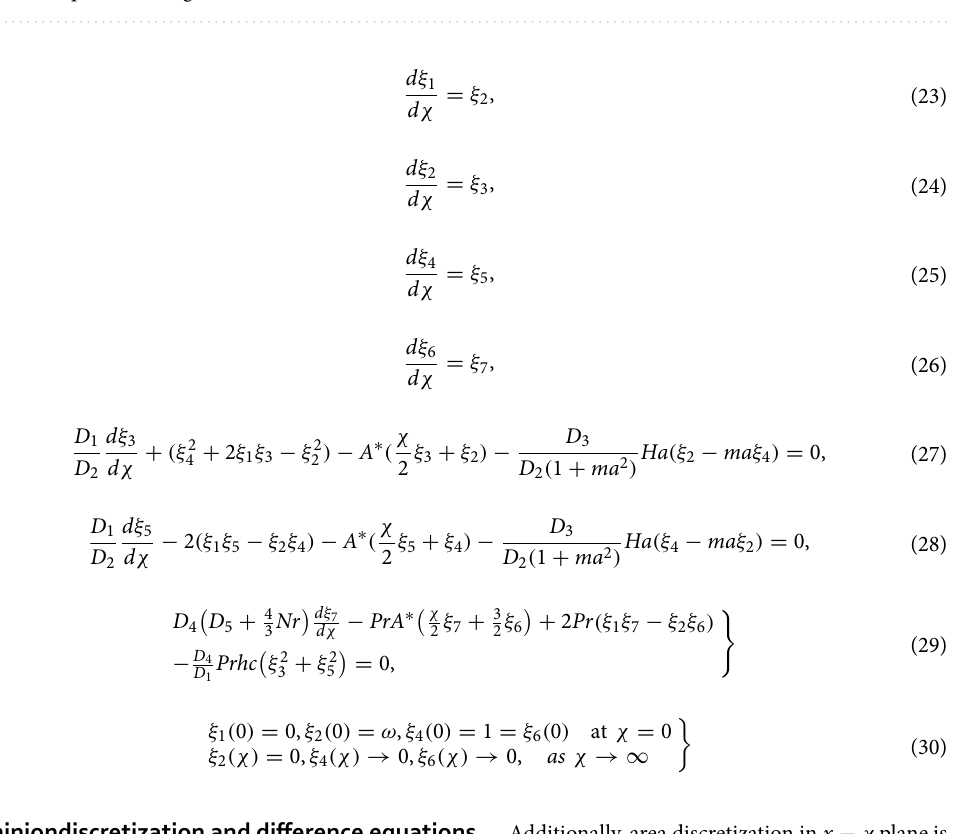
Figure 4. Representative grid structure for modification